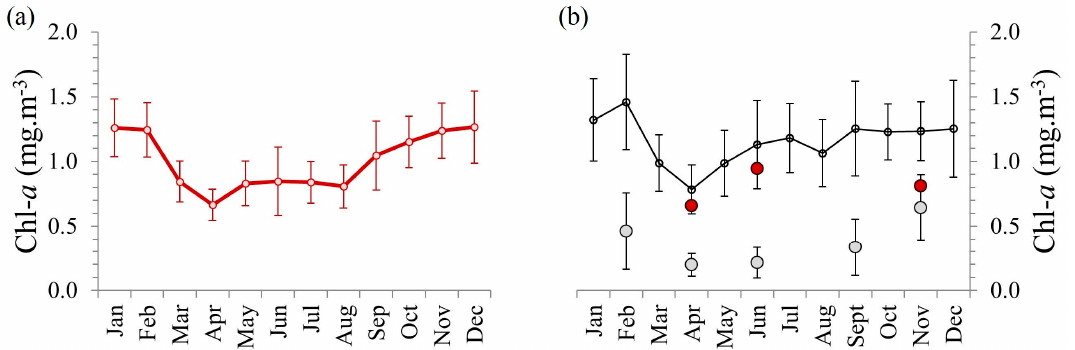
Figure 3. Monthly time-series climatologies of Chl- a (mg · m − 3 ). ( a ) Red series represent the open region of the Arabian Gulf. Climatology calculated as monthly average over 1998-2013.Vertical error bars indicate ± standard deviation ( b ) Black series represent the study area, grey dots represent in situ Chl- a averaged over first optical depth, and the red dots represent OC-CCI Chl- a data averaged on sampling months. Vertical error bars indicate ± standard deviation.